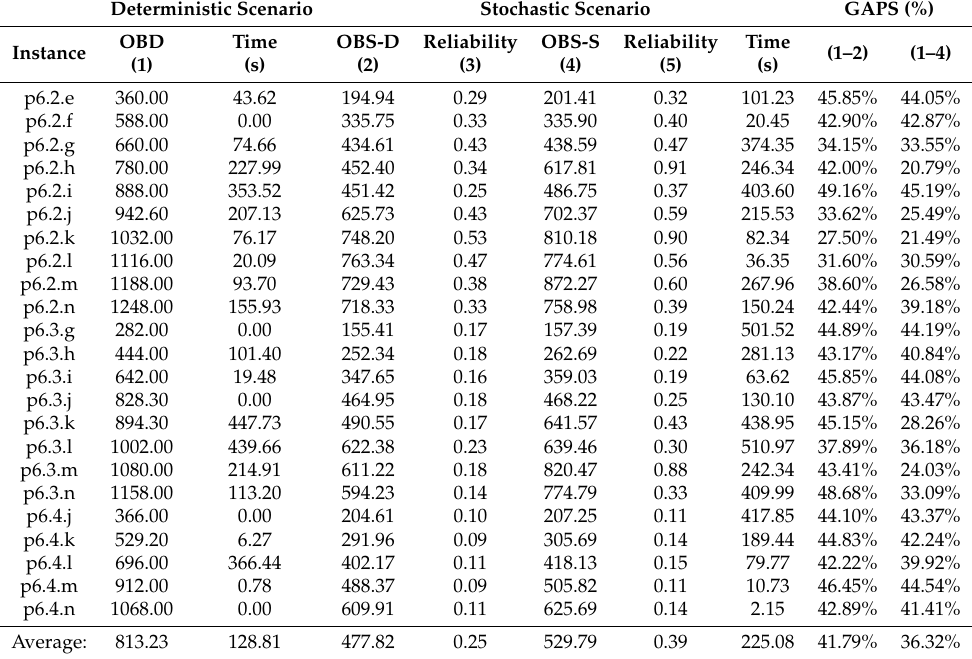
Table 11. Results for p 6 instances in a stochastic scenario with a high variance ( c = 0.25).